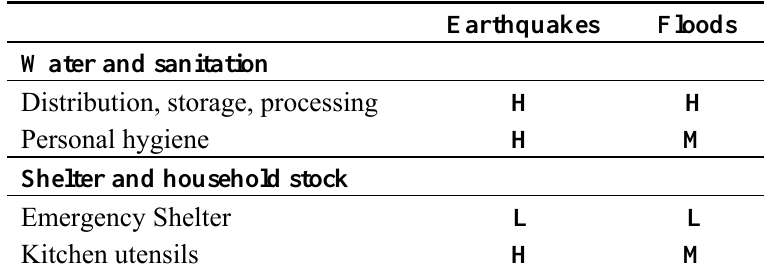
Table 2. Likelihood of Need of Relief